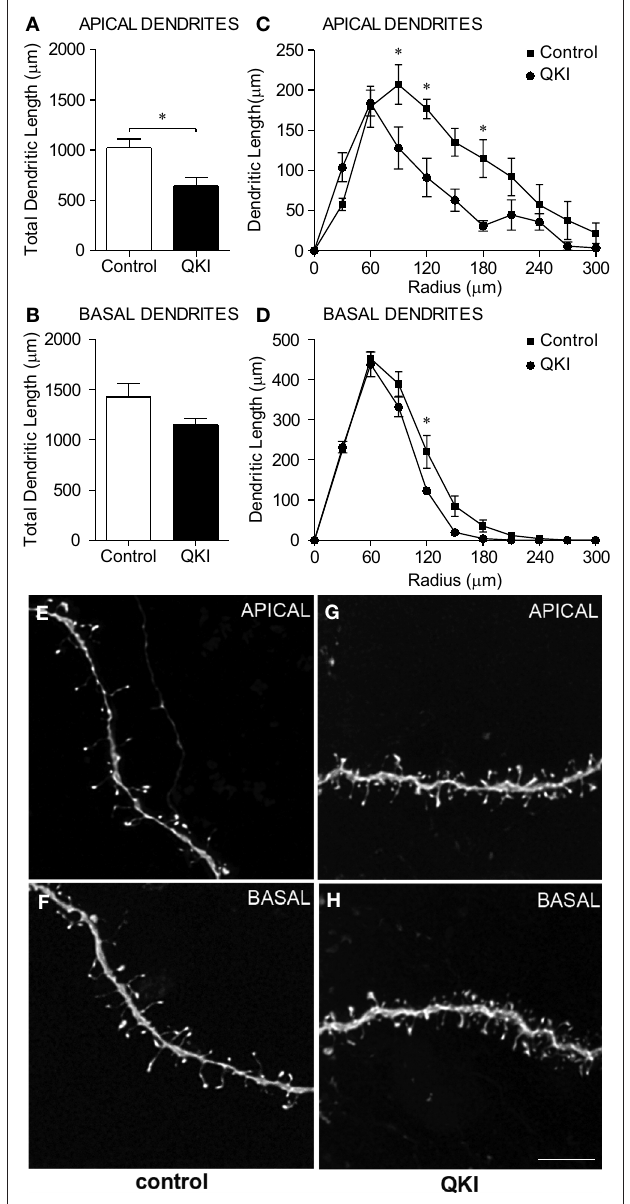
FIGURE 6 | Dendritic arbors and spines in the control and QKI mouse model. (A,B) Arbor analysis showing total dendritic lengths in apical and basal dendrites, * p < 0.05, Student’s t -test. (C,D) Dendritic lengths in apical and basal dendrites, as a function of the radial distance from the cell